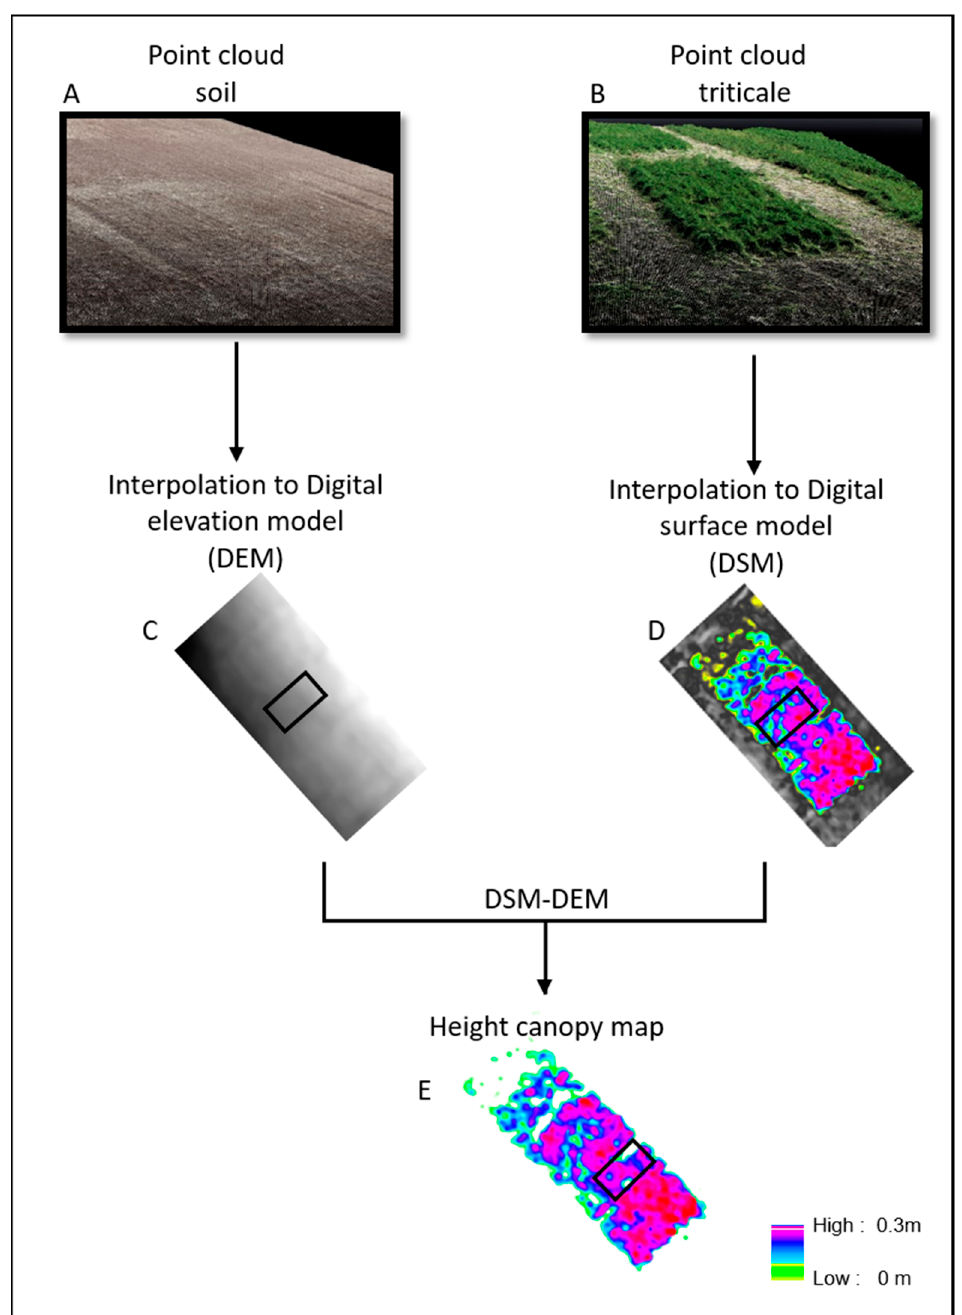
Figure 5. A workflow diagram of the 3-D canopy morphological parameters extracted for the triticale plant in the field trial using the UAV images. 3-D point cloud of the experimental plots ( A ) before and ( B ) after the triticale emergence and development, the corresponding ( C ) Digital Elevation Model (DEM) and ( D ) Digital Surface Model (DSM), and ( E ) their subtraction result, canopy height model.